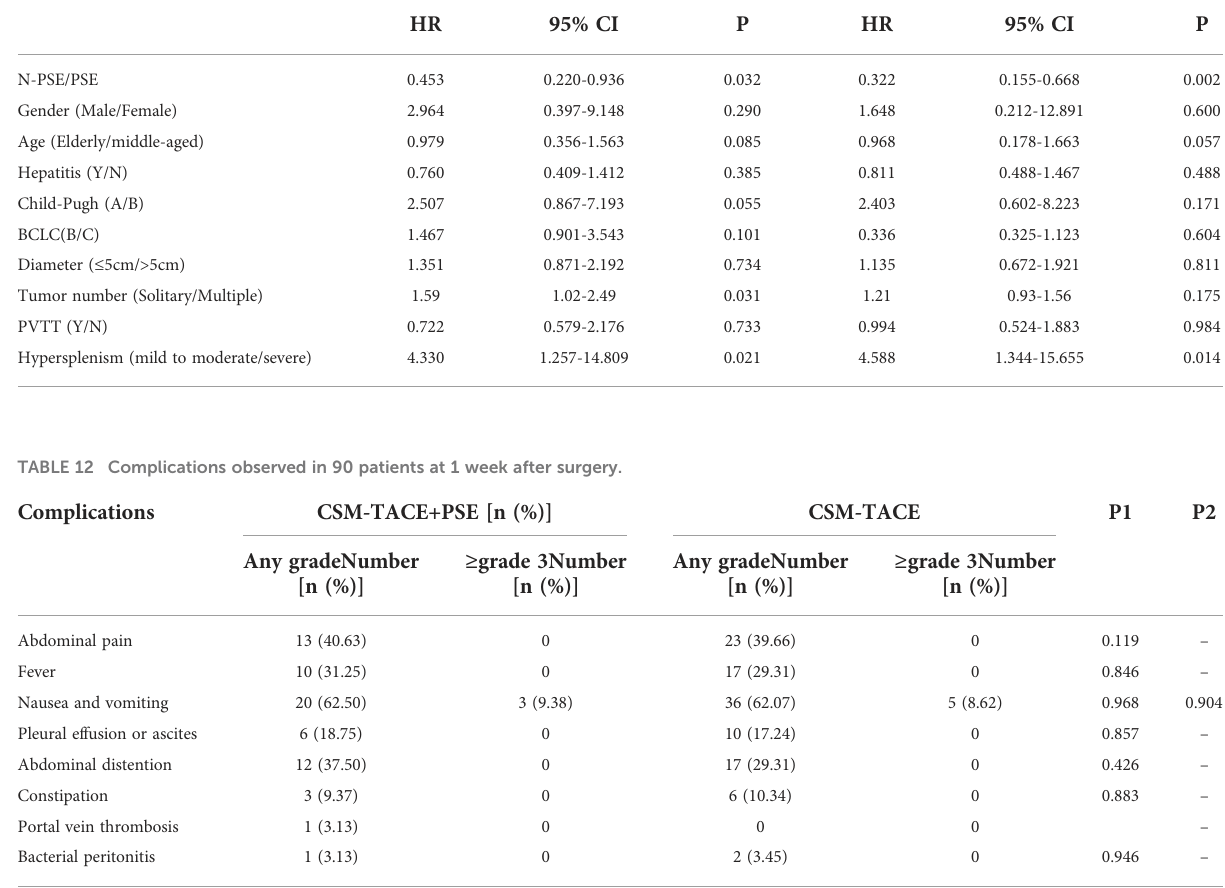
P1: Comparison of total adverse events between two groups; P2: Comparison of grade ≥ 3 adverse events between two